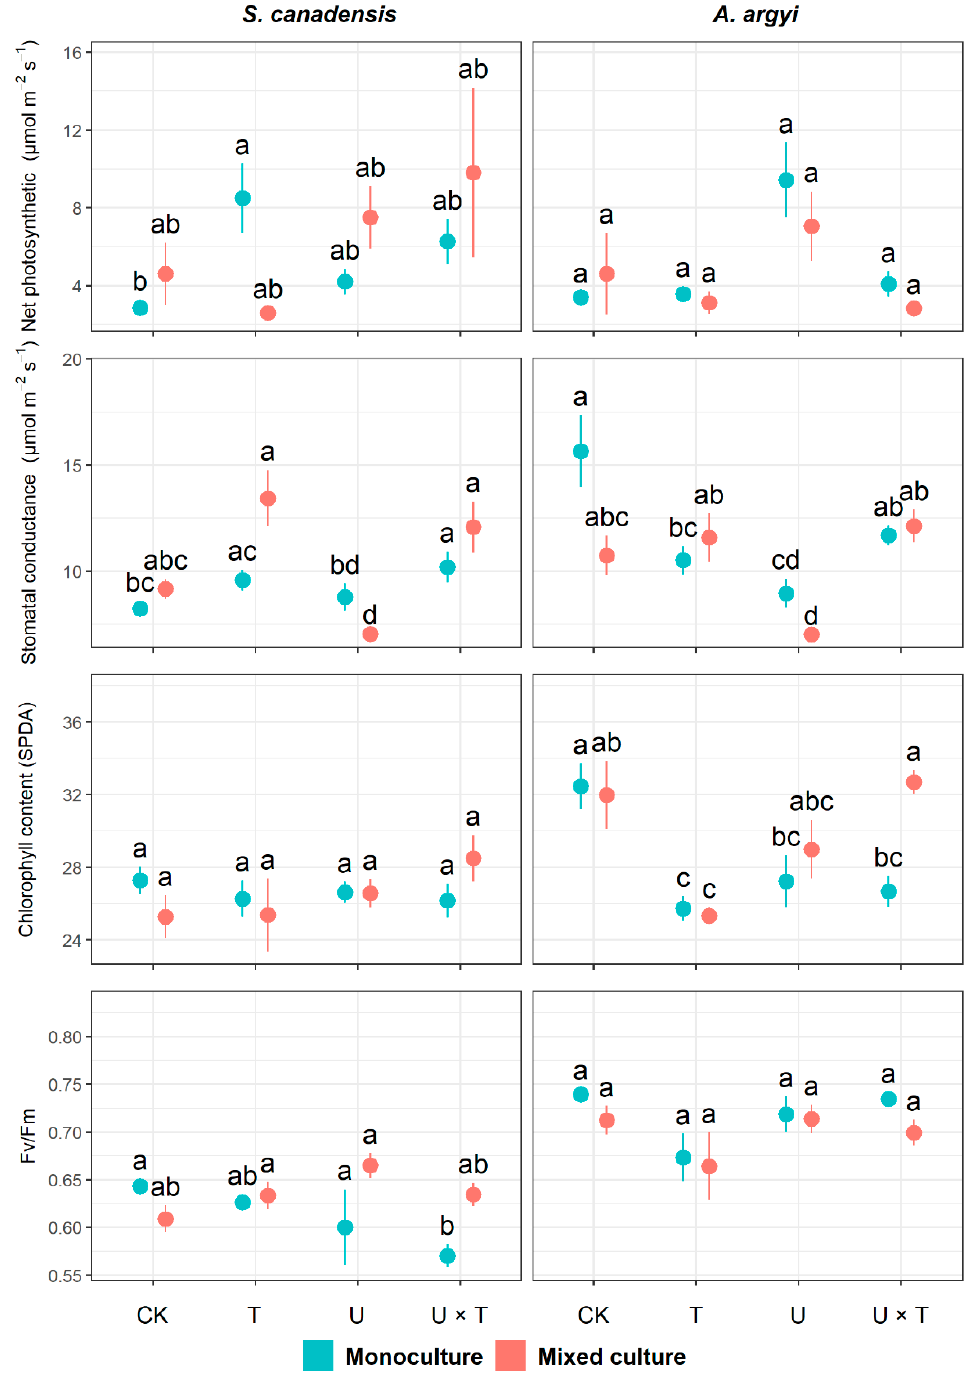
Figure 2. Effects of temperature and UV light on photosynthetic traits of the invasive Solidago canadensis and the co-occurring native species, Artemisia argyi, across plant communities (i.e., invasive species only, native species only, and mixed community). Each plant community was grown under four different treatments: ambient temperature and ambient UV (control group, CK), warming and ambient UV (T), ambient temperature and high UV (U), and high UV and warming (U × T). The solid data points represent the arithmetic mean, and the bars indicate the standard error (±SE). Significant differences ( p < 0.05) among treatments are denoted by different letters above the data points.